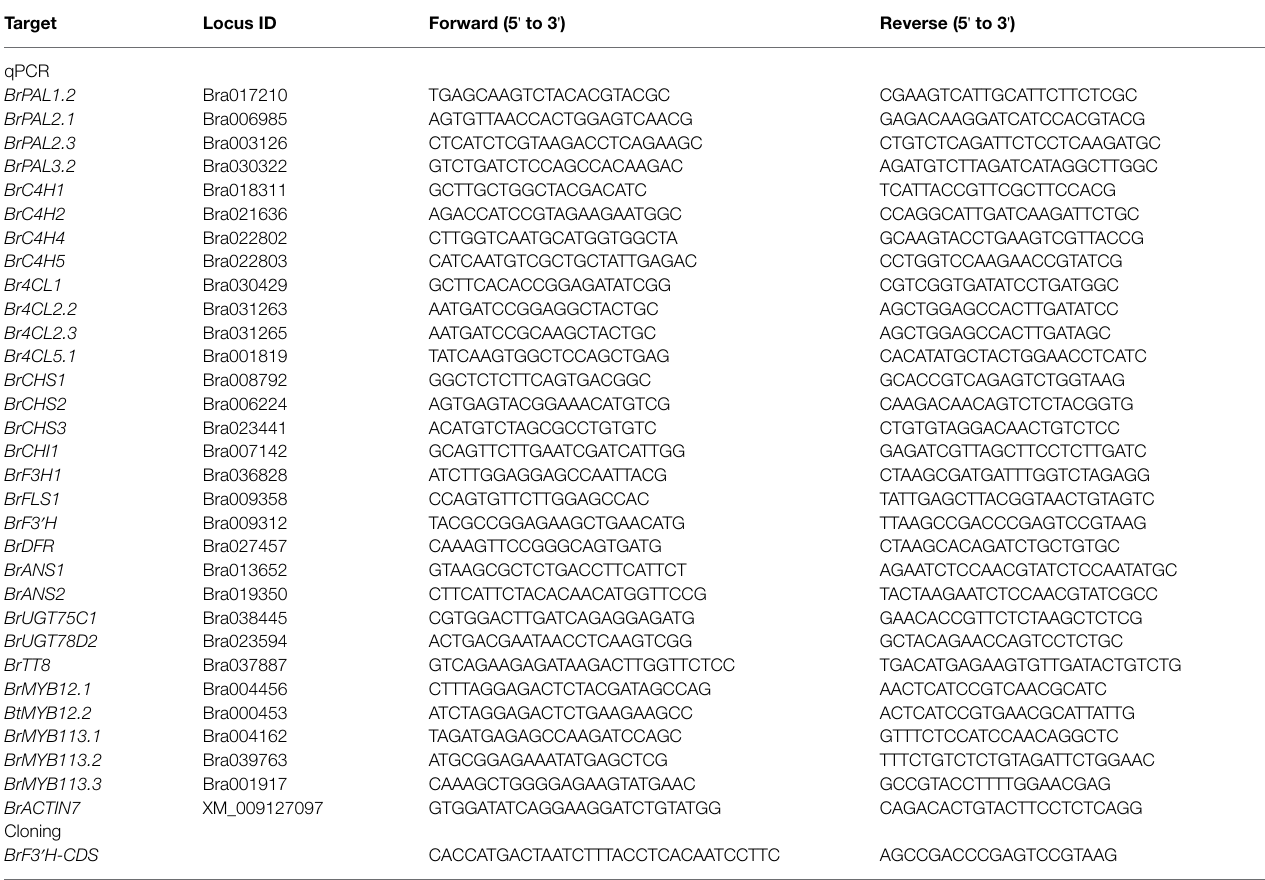
TABLE 1 | Primers used for qPCR and cloning of BrF3 ′ H coding sequence.